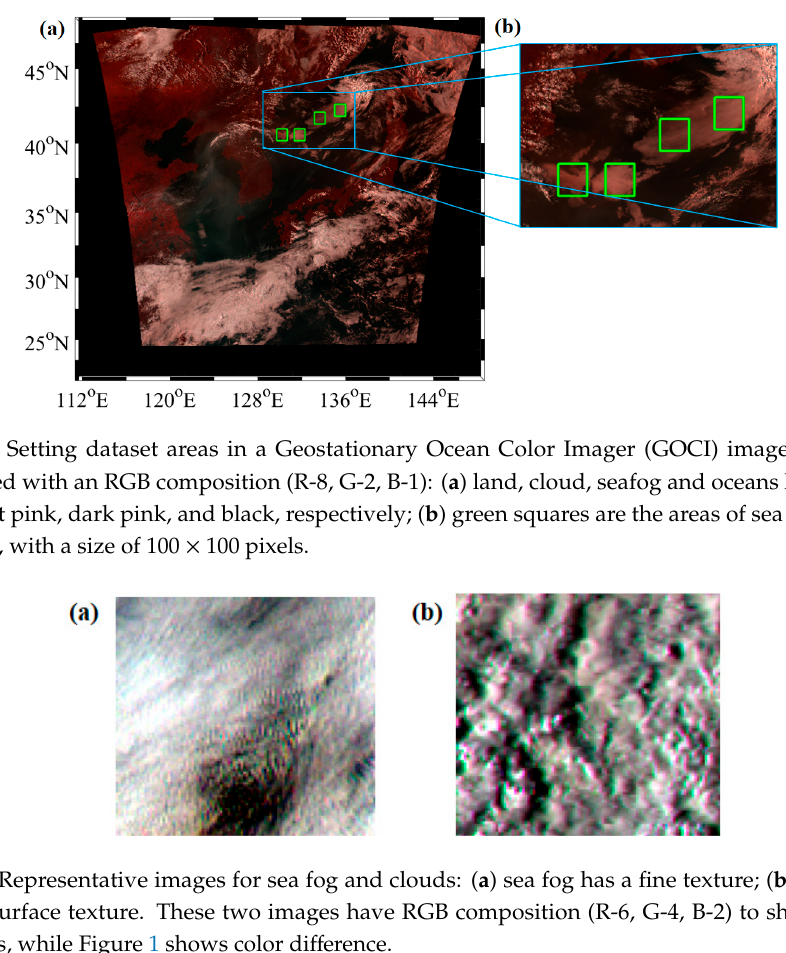
Table 1. Parameters of the Convolution Neural Network (CNN) model used in this study.